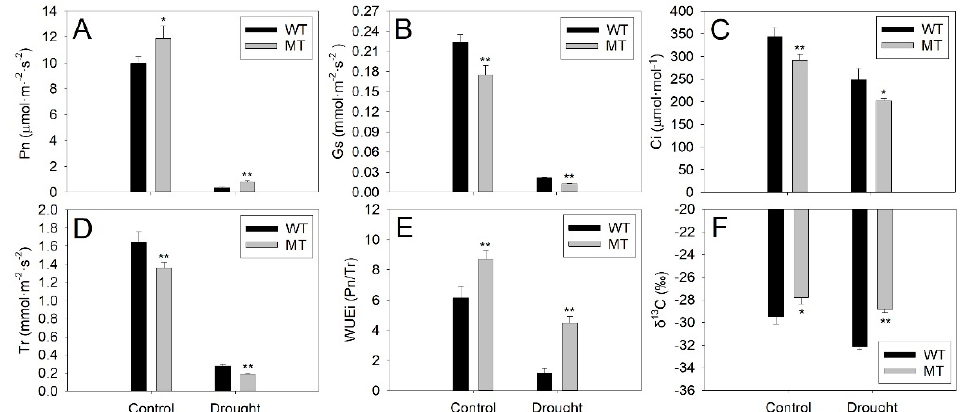
Figure 5. Analyses of photosynthetic indexes and water use efficiency (WUE) of WT and MT plants under control (well-watered) and drought conditions (without watering for 21 days). The ( A ) net photosynthetic rate (Pn), ( B ) stomatal conductance (Gs), ( C ) intercellular CO 2 concentration (Ci) and ( D ) transpiration rate (Tr) were measured by a LI-6400 photosynthetic system. ( E ) The Pn/Tr was used to calculate instantaneous water use efficiency (WUEi). Vertical bars represent standard deviations of the means ( n = 15). ( F ) The leaf’s δ 13 C were used to represent the short-term WUE in the whole plant. Vertical bars represent standard deviations of the means ( n = 3). Significant differences between WT and MT leaves at the p < 0.05 and p < 0.01 levels were indicated by * and **, respectively, according to Student’s t -test.